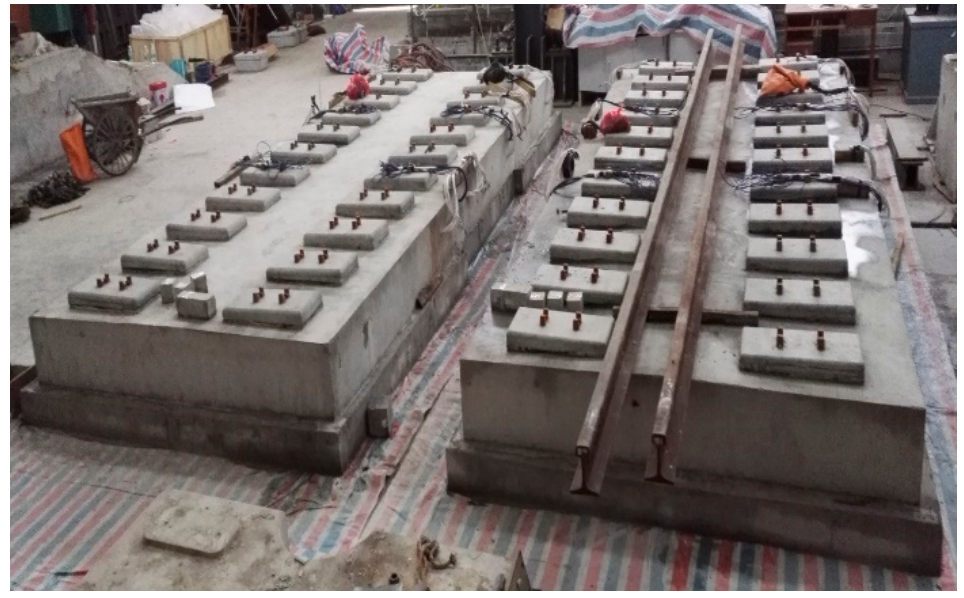
Figure 10. Full-scale test model.